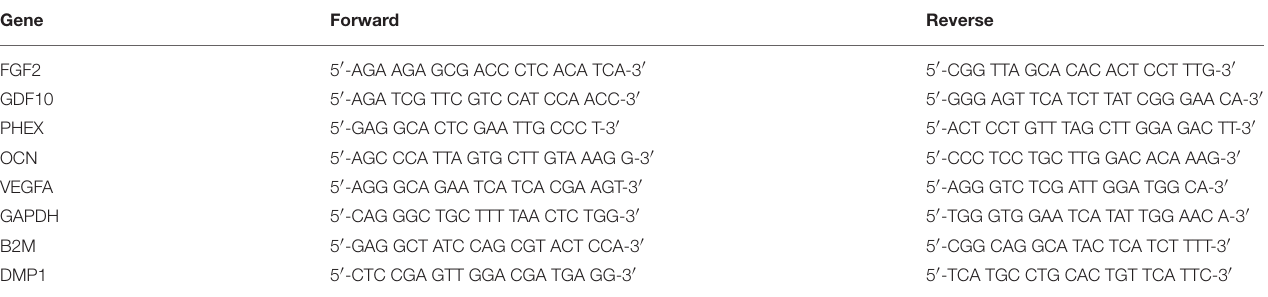
Table showing the forward and reverse primer sequences for the genes used in the real time PCR analyses.